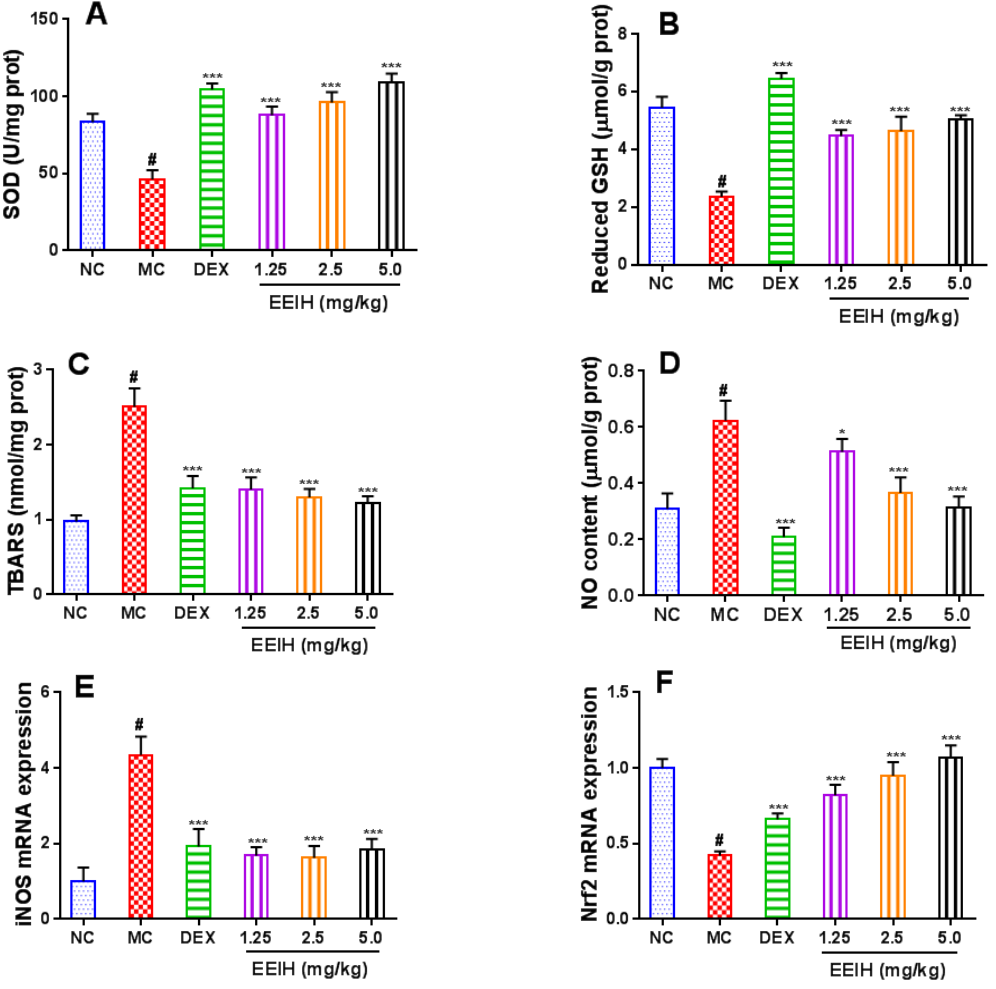
Figure 7. Effects of EEIH on SOD ( A ), reduced GSH ( B ), TBARS ( C ), and NO ( D ) levels as well as the mRNA expression of iNOS ( E ) and Nrf2 ( F ) in liver tissue of LPS-treated mice. The values are presented as the means ± SD ( n = 5). P values were determined by ANOVA and a Tukey post-hoc test. Significant differences compared to the normal control group (NC) are designated as # p < 0.001, those compared to model control group (MC) as * p < 0.05 and *** p < 0.001.